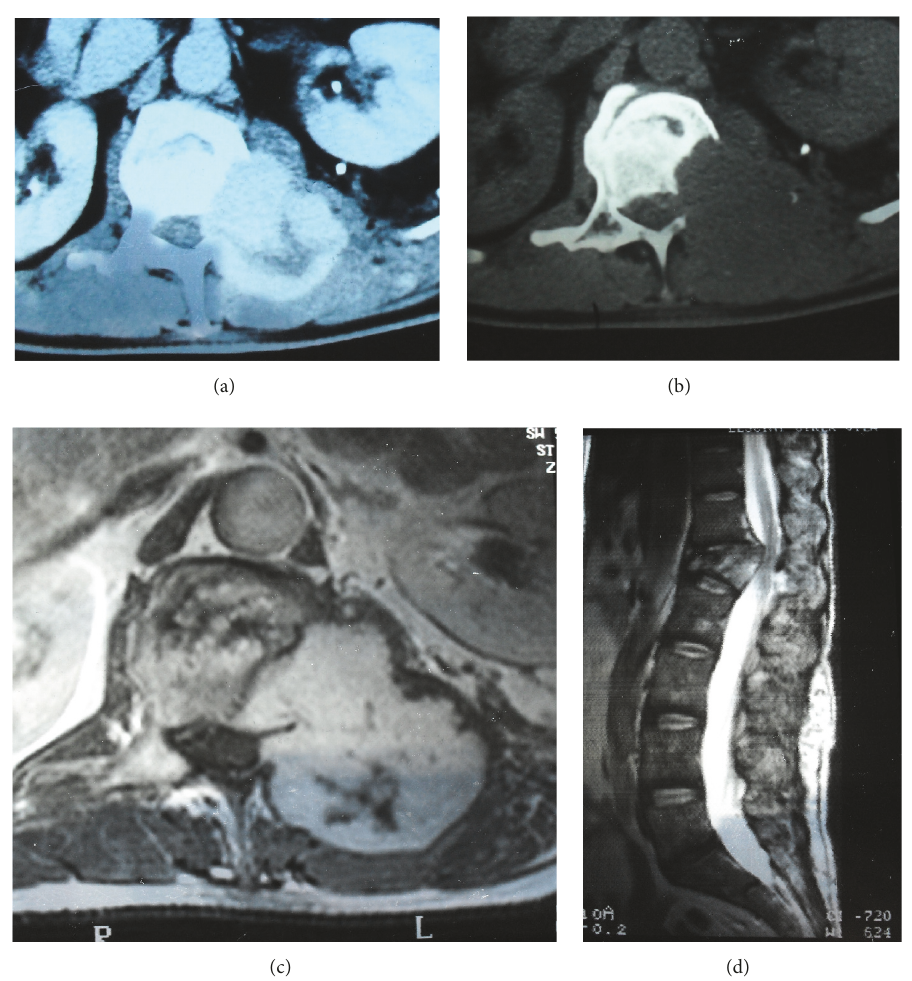
Figure 2: (a) CT: enhancing mass that has destroyed the left half of the body, left pedicle, and left transverse process of the L1 vertebra. (b) CT: bone window, partial destruction of the L1 body, absence of the left pedicle, and left transverse process. (c) MRI, axial T 1 WI, with gadolinium: mass of L1 vertebra destroying the body and compressing the paraspinal soft tissue. (d) MRI, sagittal T 2 WI: the hemangioma invading the spinal